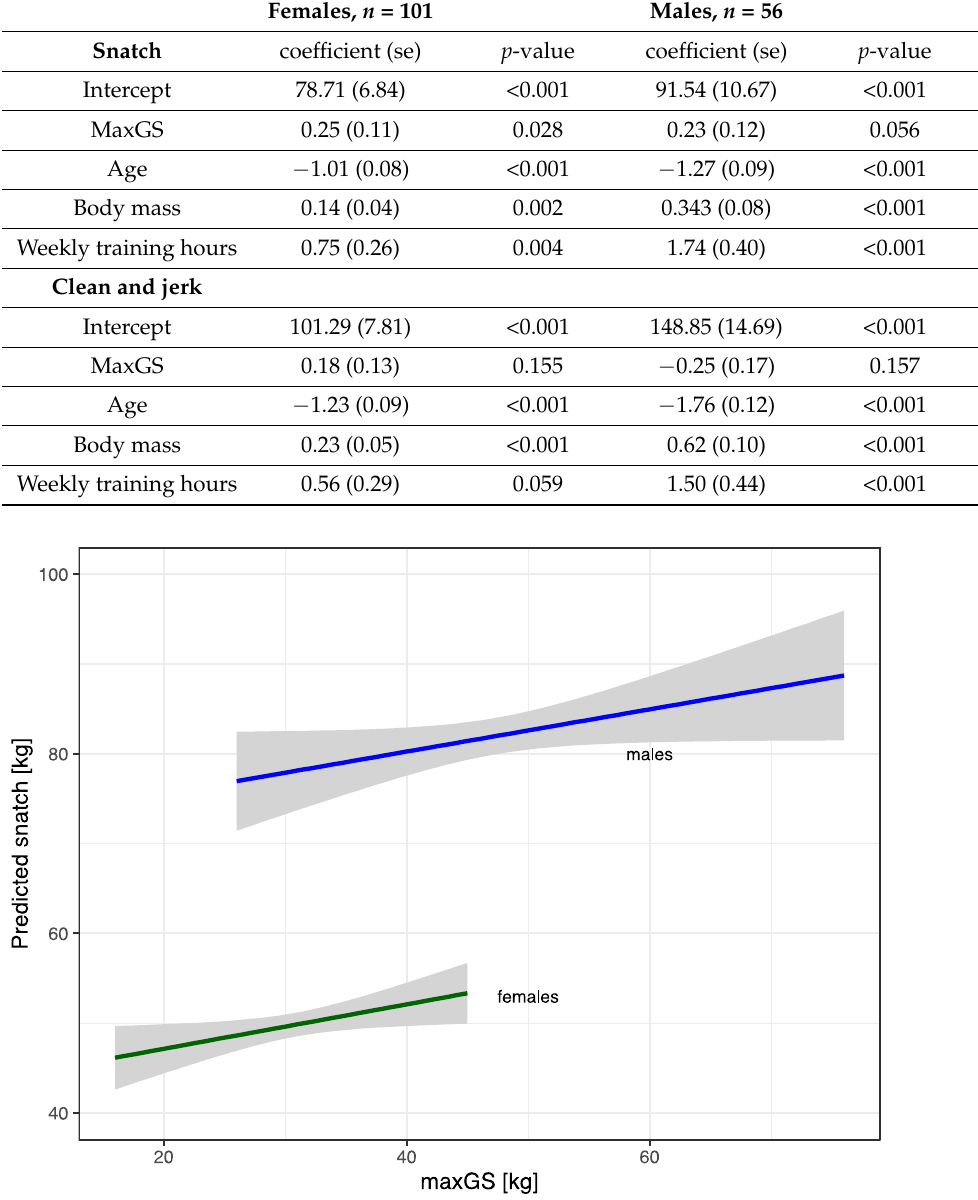
Table 3. Association of weightlifting performance with grip strength.